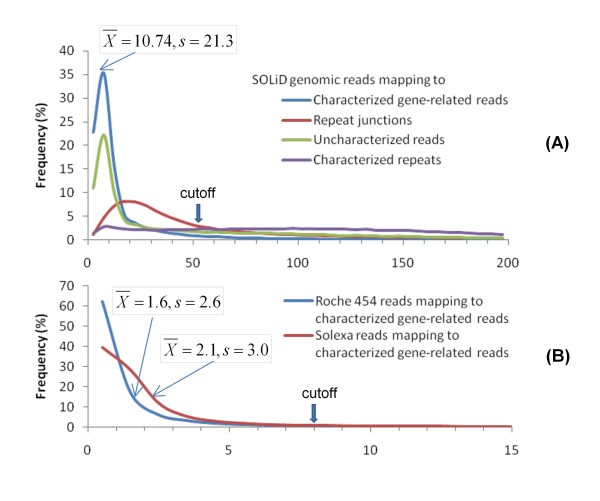
Frequency distributions of the depths of NGS reads of AS75 mapped to annotated Roche 454 reads. Except that for characterized repeat reads, the remaining distributions can be approximated to an extreme value distribution. (A) Frequency distributions of the depths of AS75 SOLiD genomic reads (total ~ 26X genome equivalents) mapped to Roche 454 characterized gene reads, repeat junction reads, characterized repeat reads, and uncharacterized reads. Because most gene-related reads are single copy, the frequency distribution of reads mapped to gene-related reads is used as single-copy read distribution. The estimated population mean (X¯) plus two standard deviations (s) (depth of 53X) of this distribution was used as the cut-off depth for considering AS75 SOLiD genomic reads mapped on Roche 454 AL8/78 gene reads, repeat junctions, and uncharacterized reads as single-copy. (B) Frequency distributions of read depths and X¯ + 2s cut-off values for Solexa AS75 genomic reads (~1.56X genome equivalent) and Roche 454 AS75 genomic reads (~0.11X genome equivalent) mapped to characterized gene reads of Roche 454. The distributions were skewed to the left because of low coverage but still could be fitted to an extreme value distribution (a Weibull distribution) [34].